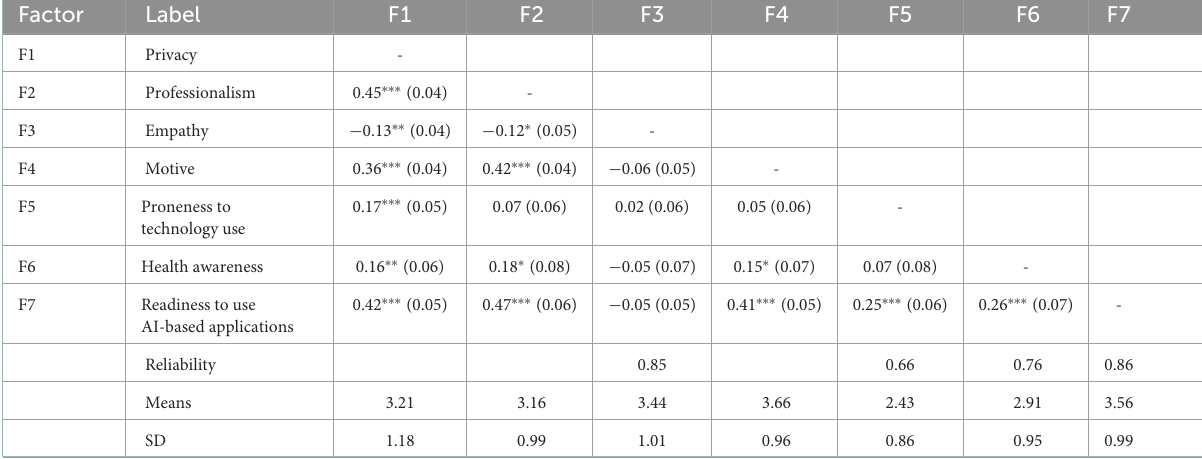
TABLE 2 CFA - Correlations between the factors.